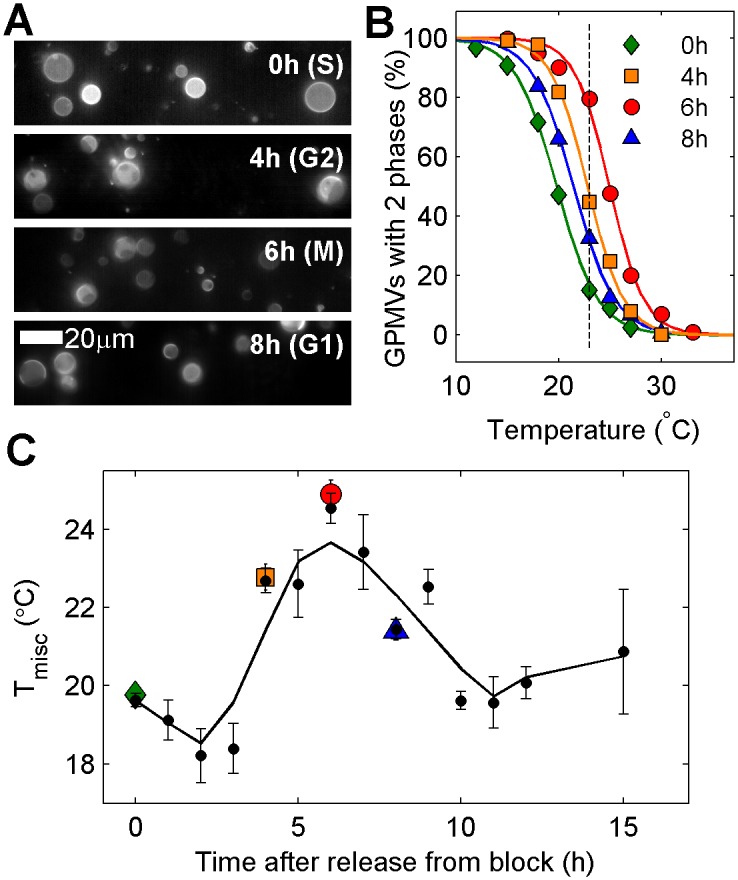
Transition temperatures vary systematically as RBL-2H3 cells synchronized to the G1/S boundary progress through the cell cycle.(A) Representative fields of GPMVs prepared at the indicated time-points after release from a double thymidine block and imaged at 23°C. GPMVs isolated immediately after release from block (top) are mostly in a single phase whereas GPMVs isolated at later time-points often contain two phases in coexistence. (B) The fraction of phase separated GPMVs as a function of temperature for GPMVs isolated at the indicated times after release from block. These curves are used to quantify the average transition temperature (Tmisc). The dashed line is drawn at 23°C for comparison to A. (C) Tmisc as a function of time after release from the double thymidine block. Larger colored symbols represent values obtained in B and black symbols include data from 4 separate trials. The black line is smoothed from black points using a lowess filter.